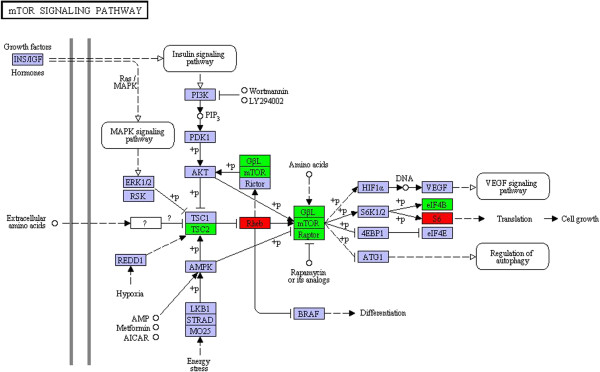
The mTOR signaling pathway in KEGG pathway analysis. The mTOR signaling pathway is among the S1-Pri-up-regulated pathways in KEGG analysis. Rheb and ribosomal protein small subunit s6e (red boxes) were identified through 5′-SAGE as DEGs in the S1-Pri stage. Expression of five other components (green boxes) were verified by real-time PCR.